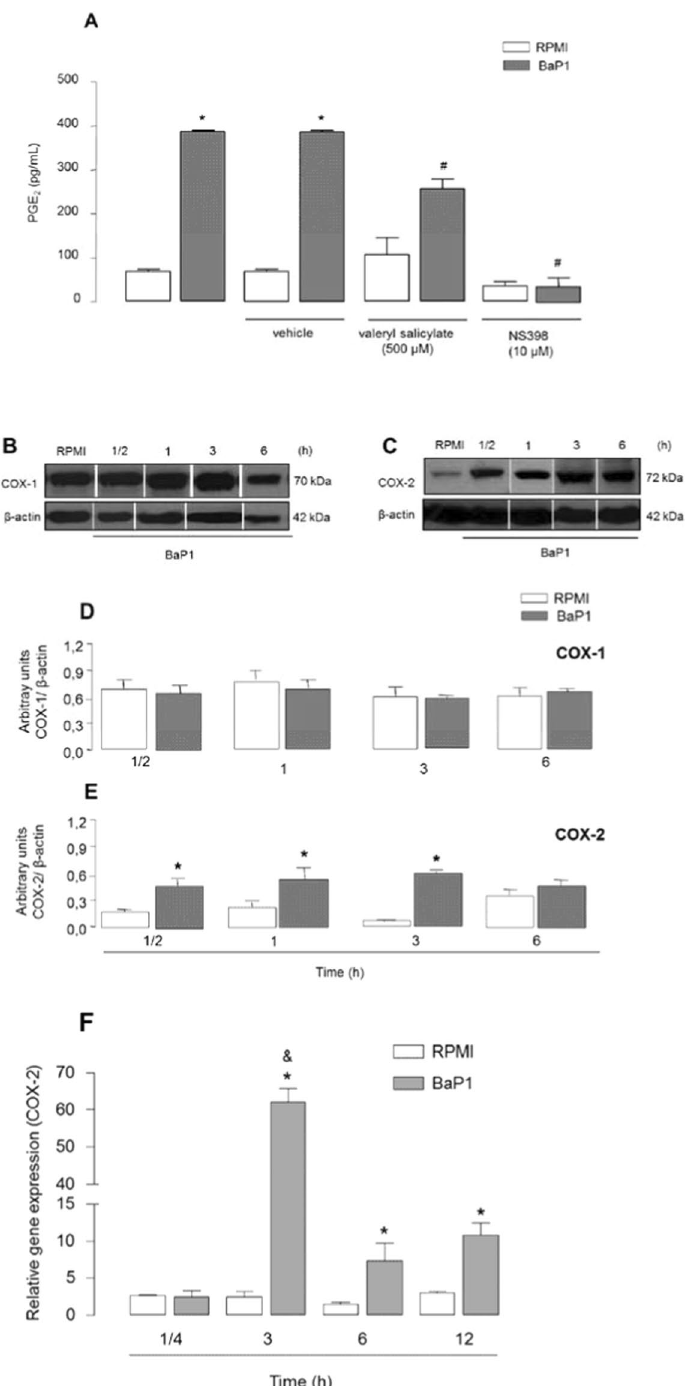
Figure 2. BaP1 activates COX-1 and -2 pathways to release PGE 2 and up-regulates COX-2 expression. ( A ) Isolated FLSs were pretreated with the selective inhibitors of COX-1 and -2, valeryl salicylate and NS398, respectively, for 1 h and incubated with BaP1 (12.5 µ g/mL) or RPMI (control) for 3 h. Supernatants were collected, and PGE 2 was quantified by ELISA. ( B–E ) FLSs were incubated with BaP1 (12.5 µ g/mL) or RPMI (control) for 30 min, 1, 3 and 6 h. ( B ) Representative Western blotting of COX-1 and β -actin (loading control) showing immunoreactive bands. ( C ) Representative Western blotting of COX-2 and β -actin (loading control) showing immunoreactive bands. Densitometric analysis of immunoreactive ( D ) COX-1 and ( E ) COX-2 bands. ( F ) COX-2 relative gene expression determined by quantitative PCR in cells incubated with BaP1 (12.5 µ g/mL) or RPMI (control) for 15 min, 3 and 6 h. Data are mean ± SEM of 3 samples. * p < 0.05 relative to control; # p < 0.05 relative to BaP1 (with vehicle); & p < 0.05 relative to BaP1 (6 and 12 h) (one-way ANOVA, Bonferroni post test in A and two-way ANOVA, Bonferroni post test in D, E and F). Blots were cropped from the full-length blots, which are demonstrated as Supplementary Figures 3(A,B) and 3(A–D) and cropped blots are indicated by